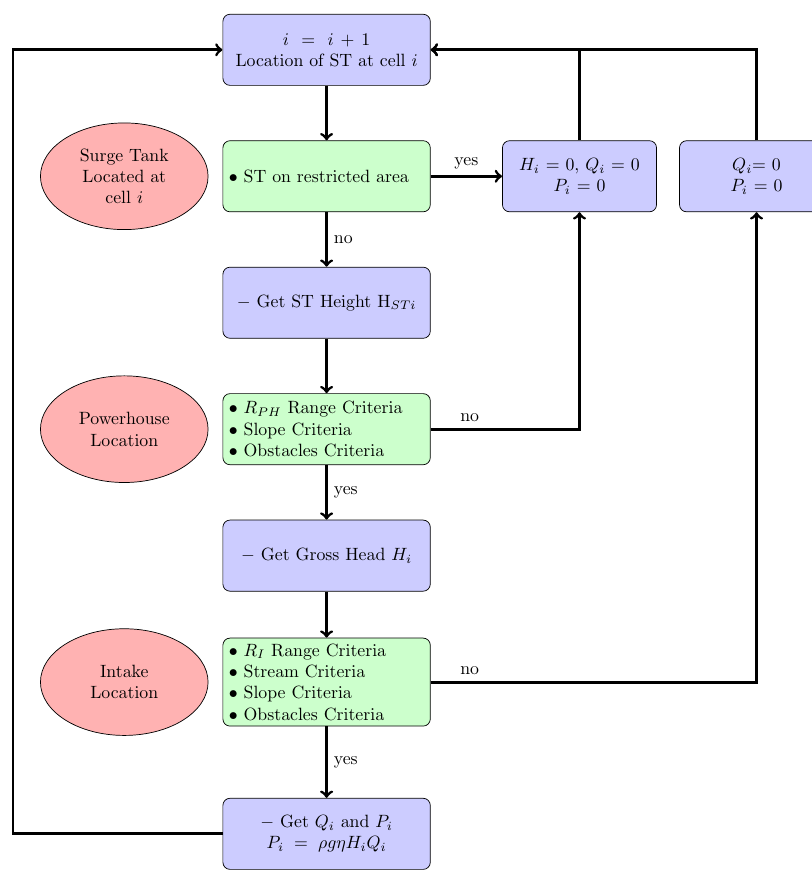
Figure 1: Mesh Sweeping Approach (MSA) methodology Flow Diagram Figure 5. Mesh sweeping approach (MSA) methodology flow